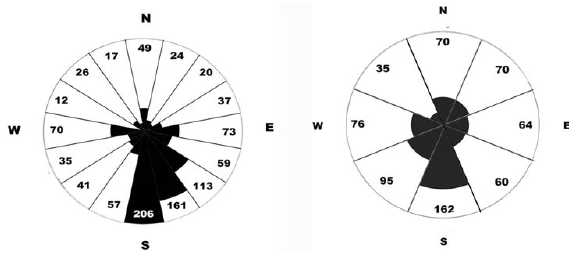
Fig. 9. Azimutal distribution of auroras recorded by Westman (left) and Sykora